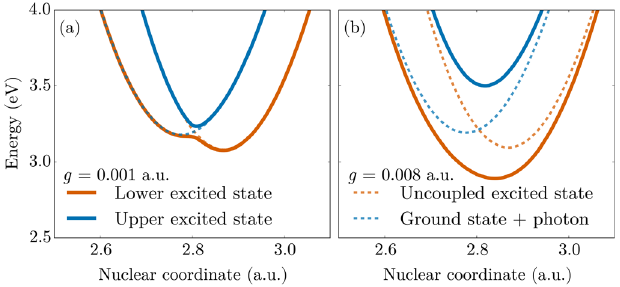
FIG. 3. Strongly coupled electronic PES (solid lines) in the singly excited subspace, for the anthracenelike molecule for (a) g ¼ 0 . 001 a : u : and (b) g ¼ 0 . 008 a : u : . The dashed lines show the corresponding uncoupled states: A molecule in the first R Þ , and a molecule in the ground state with one excited state, E e ð R Þ þ ω photon present, E g ð c